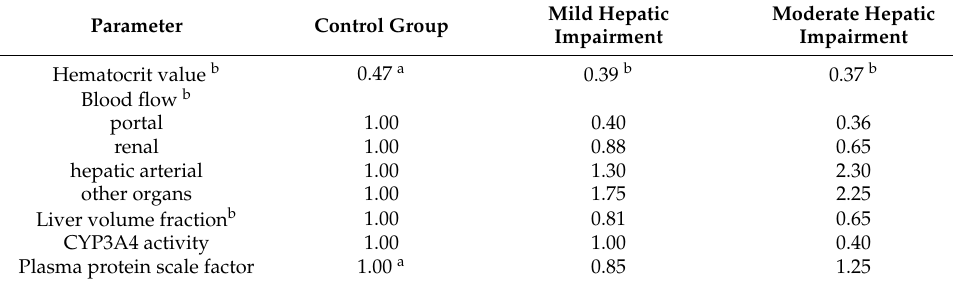
Table 3. Physiological changes of parameters associated with hepatic impairment.